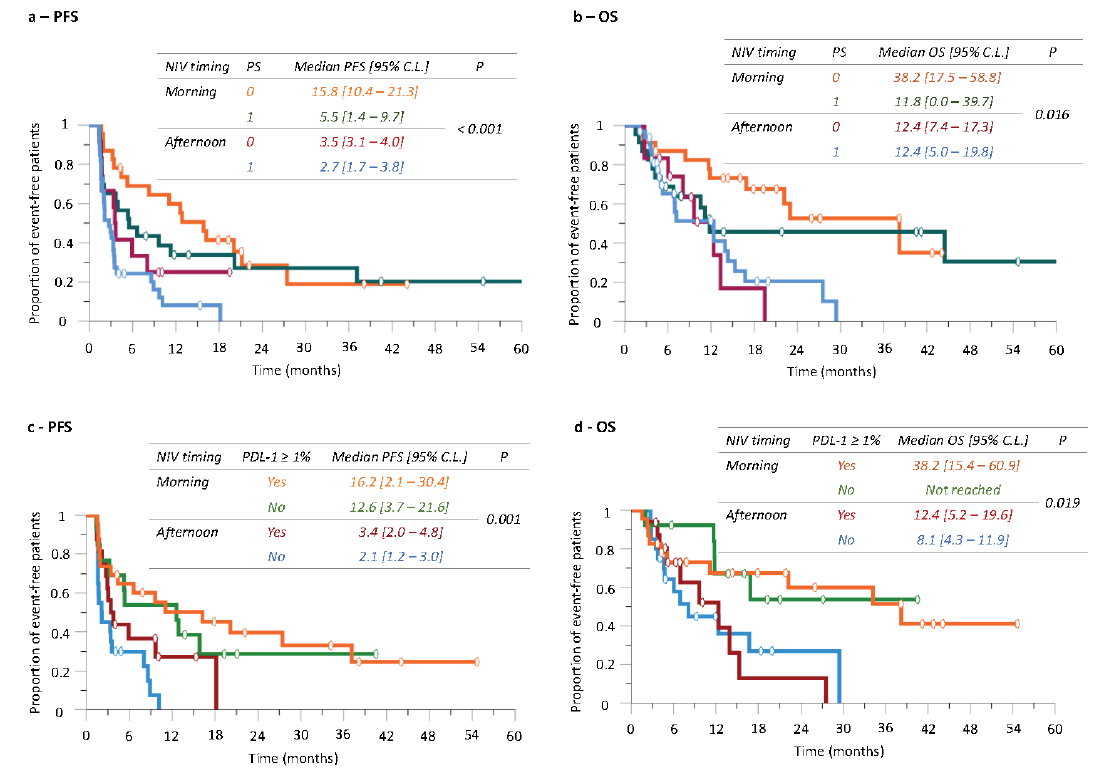
Figure 4. Kaplan–Meier curves of progression-free survival (PFS) and overall survival (OS) according